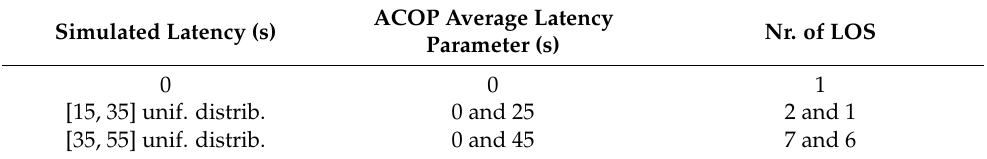
Table 6. Latency sensitivity analysis (ACOP